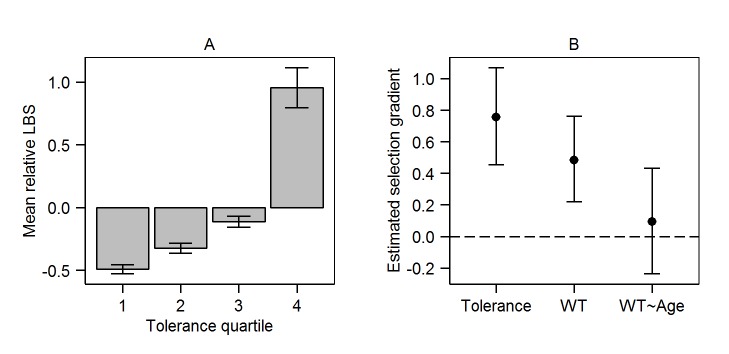
Positive phenotypic selection for increased tolerance in Soay sheep.(A) Mean relLBS is higher in individuals that were more tolerant of infections. The plot was generated from individual estimates of tolerance slopes and relLBS from the model shown in Table 2. Individuals in the four tolerance quartiles are predicted to lose varying amounts of weight between infection levels of 0 and 2,000 strongyle eggs/gram of faeces, as follows: Q1 =  loss of >2.73 kg; Q2 =  loss of 2.72–2.53 kg; Q3 =  loss of 2.52–2.34 kg; Q4 =  loss of <2.34 kg. Data plotting these estimates are shown in Table S7. (B) Estimated selection gradients calculated from the bivariate model of body weight (WT) and relLBS, which is shown in full in Table 2. Selection gradients were calculated for each of 1,000 posterior estimates of the individual VCV matrix as described in the text for individual variation in body weight; in the slope of body weight on FEC—that is, tolerance; and in the slope of body weight on age. Points show mean estimated selection gradient of each trait on LBS±95% CI. The model estimates used to generate Figure 3B are shown in Table S8.